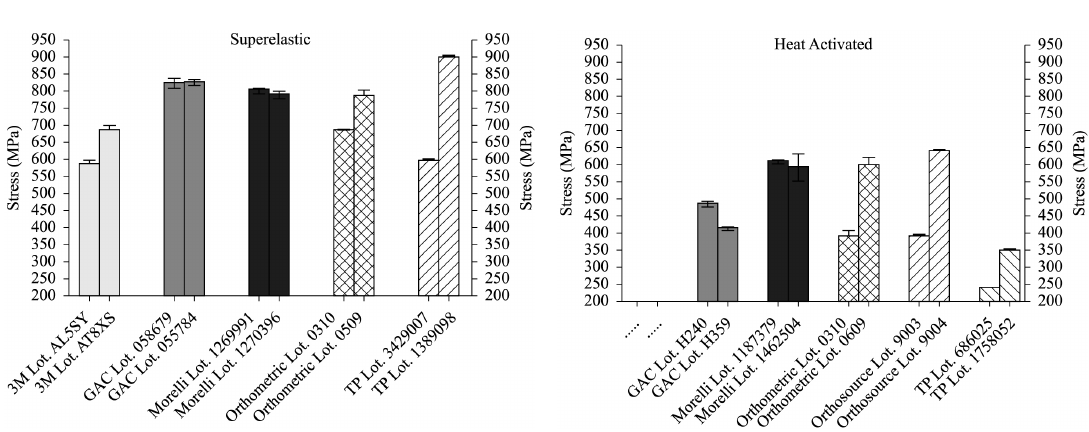
Figure 5. Mean stress (MPa) on the unloading plateau at 3.1 mm deflection of superelastic and heat activated NiTi 0.014-in inch from different orthodontic archwires lots.